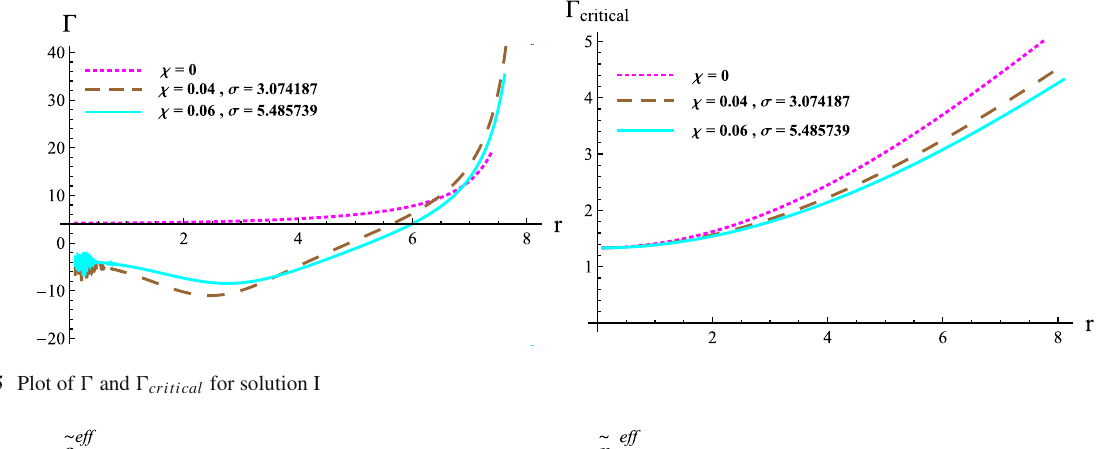
Fig. 5 Plot of (cid:20) and (cid:20) critical for solution I